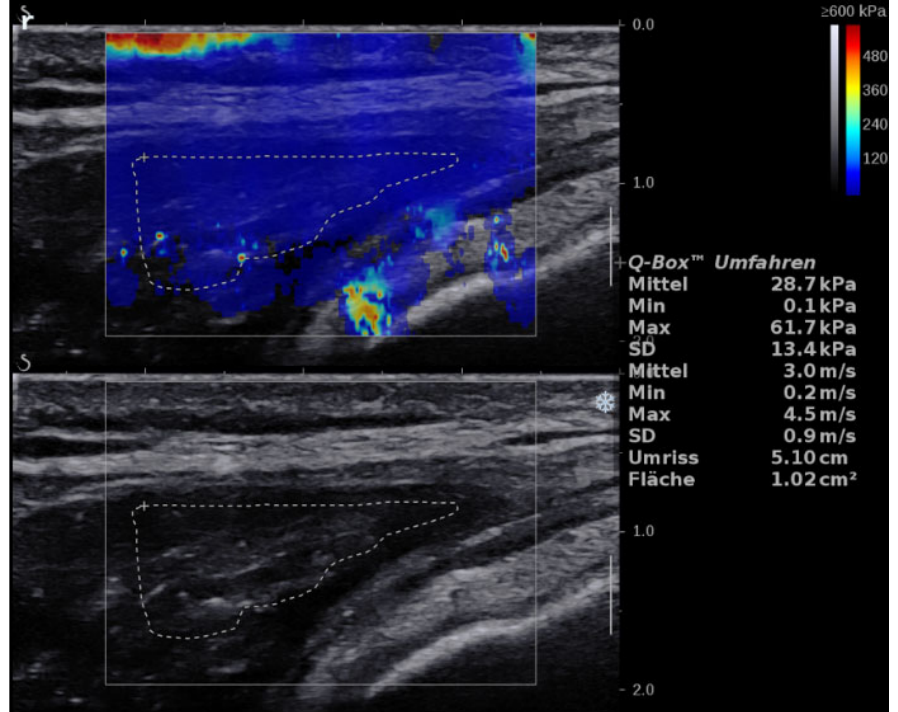
Figure 3. Axial scan of the GM muscle showing SWE and B ‐ mode. (the same patient with ITBS as in Figure 1).